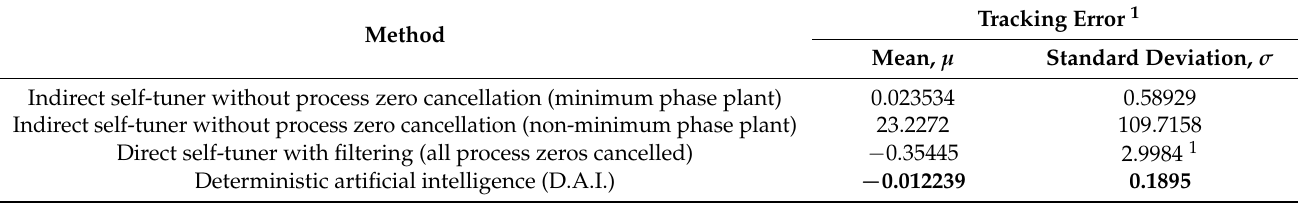
Table 2. Tracking errors‘ figures of merit (means and standard deviations) for each technique.